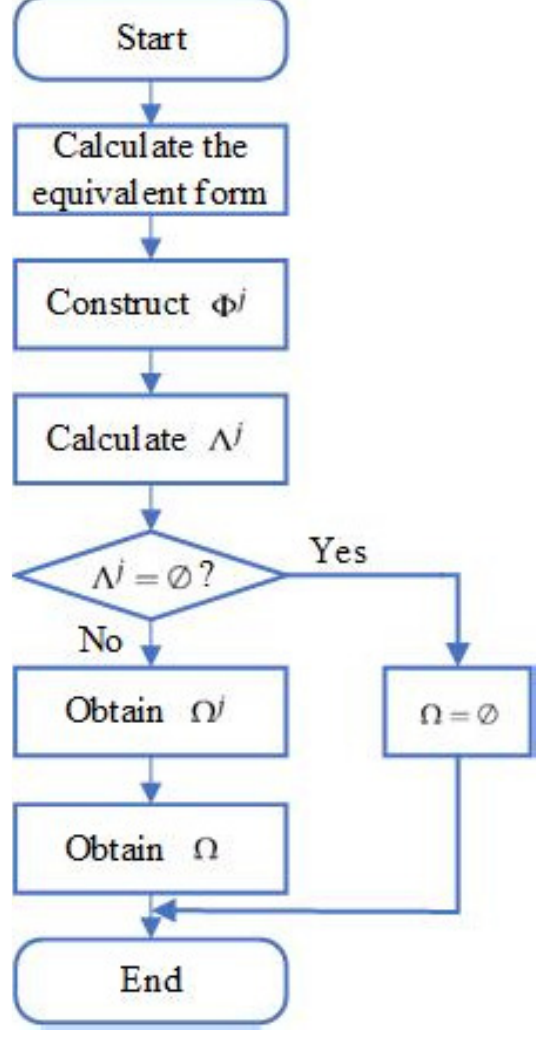
Figure 1. Flowchart of obtaining all the solutions to FRI (11) (resp. SFRIs